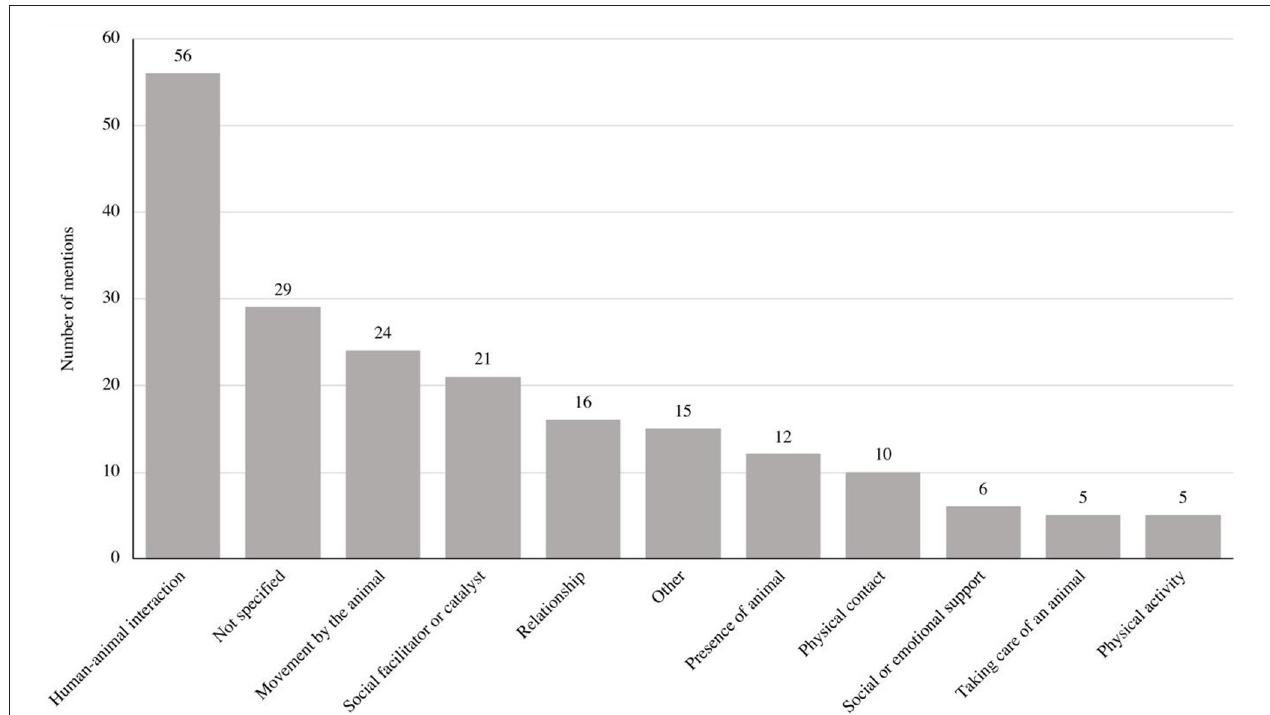
FIGURE 2 | Number of identified factor hypotheses.